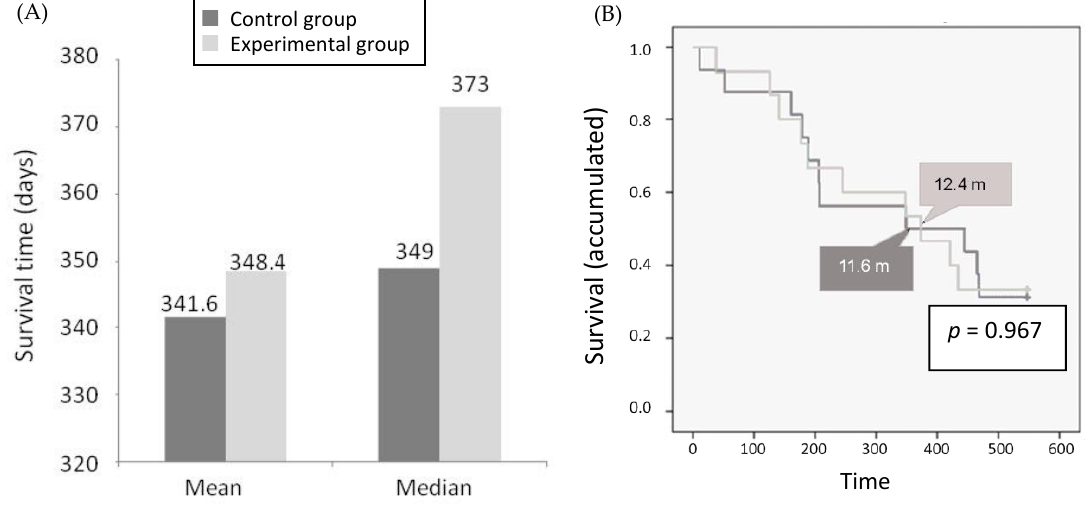
Figure 2. Survival by treatment group. ( A ) Survival (mean and median, days); ( B ) overall survival (OS) (median, days) estimated from the date of randomization to the date of death from any cause. Patients alive at the end of the study were censored at their last contact date.